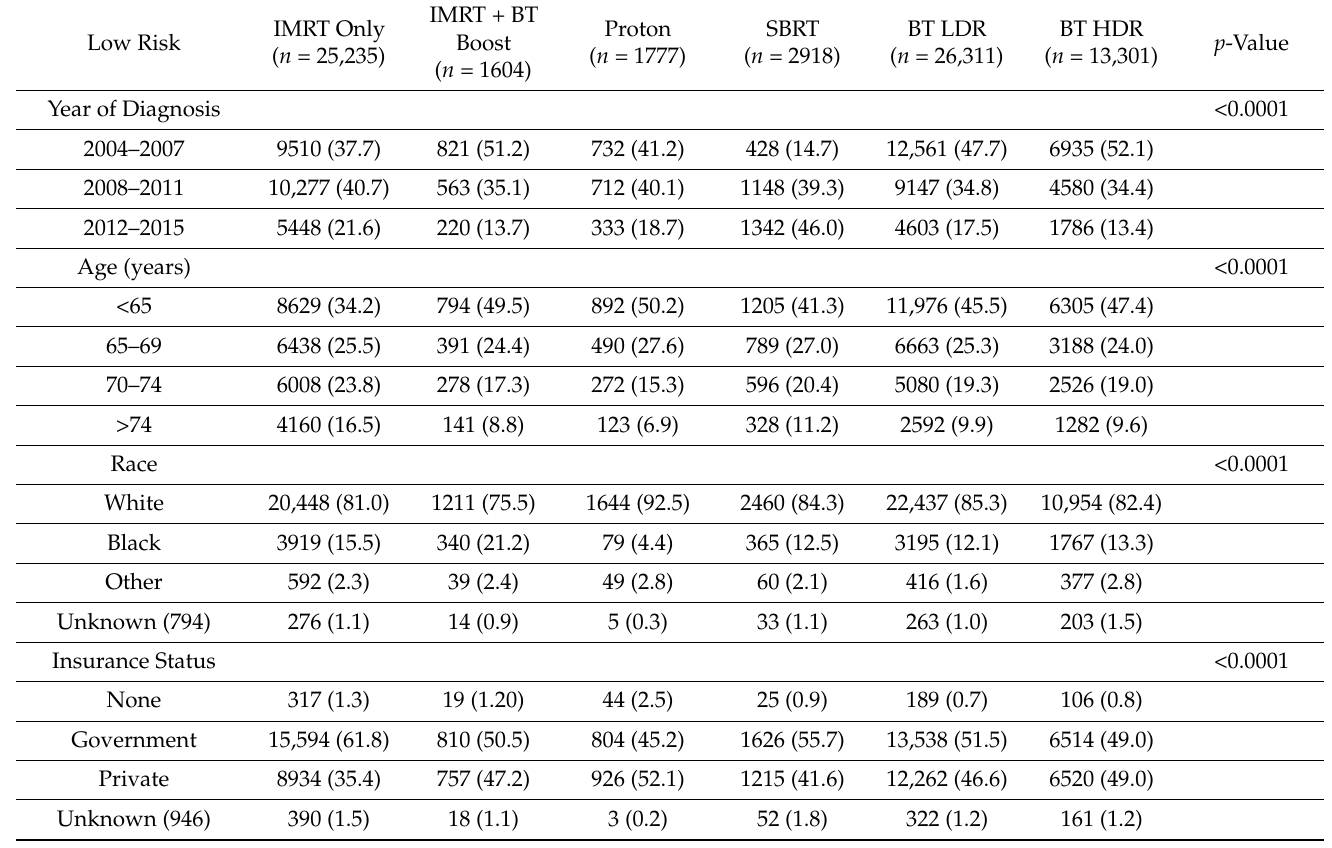
Table 3. Comparative utilization of the six treatment modalities for low-risk prostate cancer